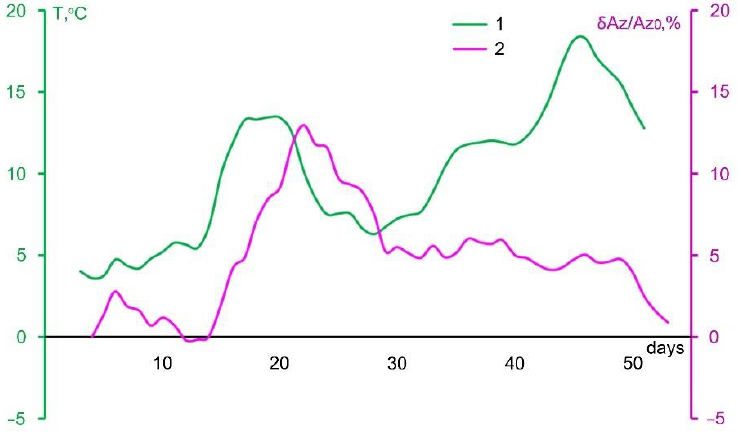
Figure 7. Evolution of amplitude A Z fluctuations and average daily value air temperature T during the experimental session from 23 April to 15 June 2019: 1—temperature, 2— δA Z / A Z0 .